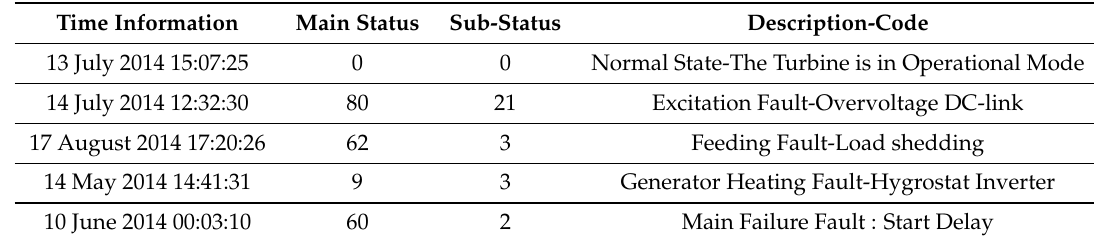
Table 1. Wind Energy Converter Normal/Faulty